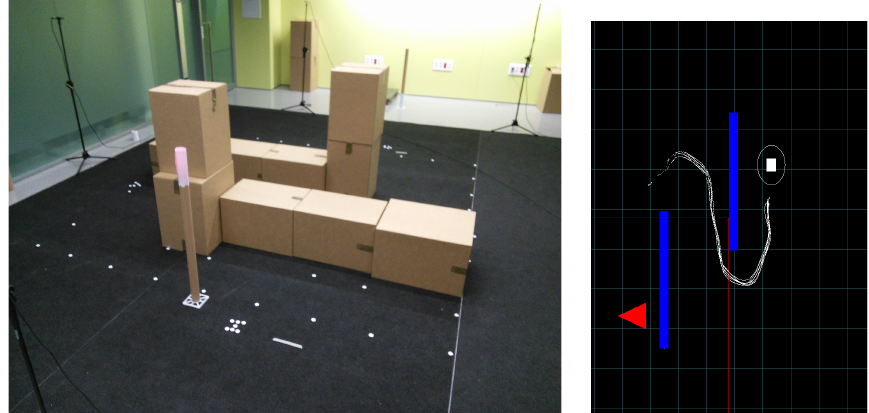
Figure 3. ( Left ) Real environment. The pole marks the position of the goal. The pedestrian is placed initially opposite to the pole after the farthest wall in the picture. ( Right ) Several sampled real trajectories displayed in the 3D environment.